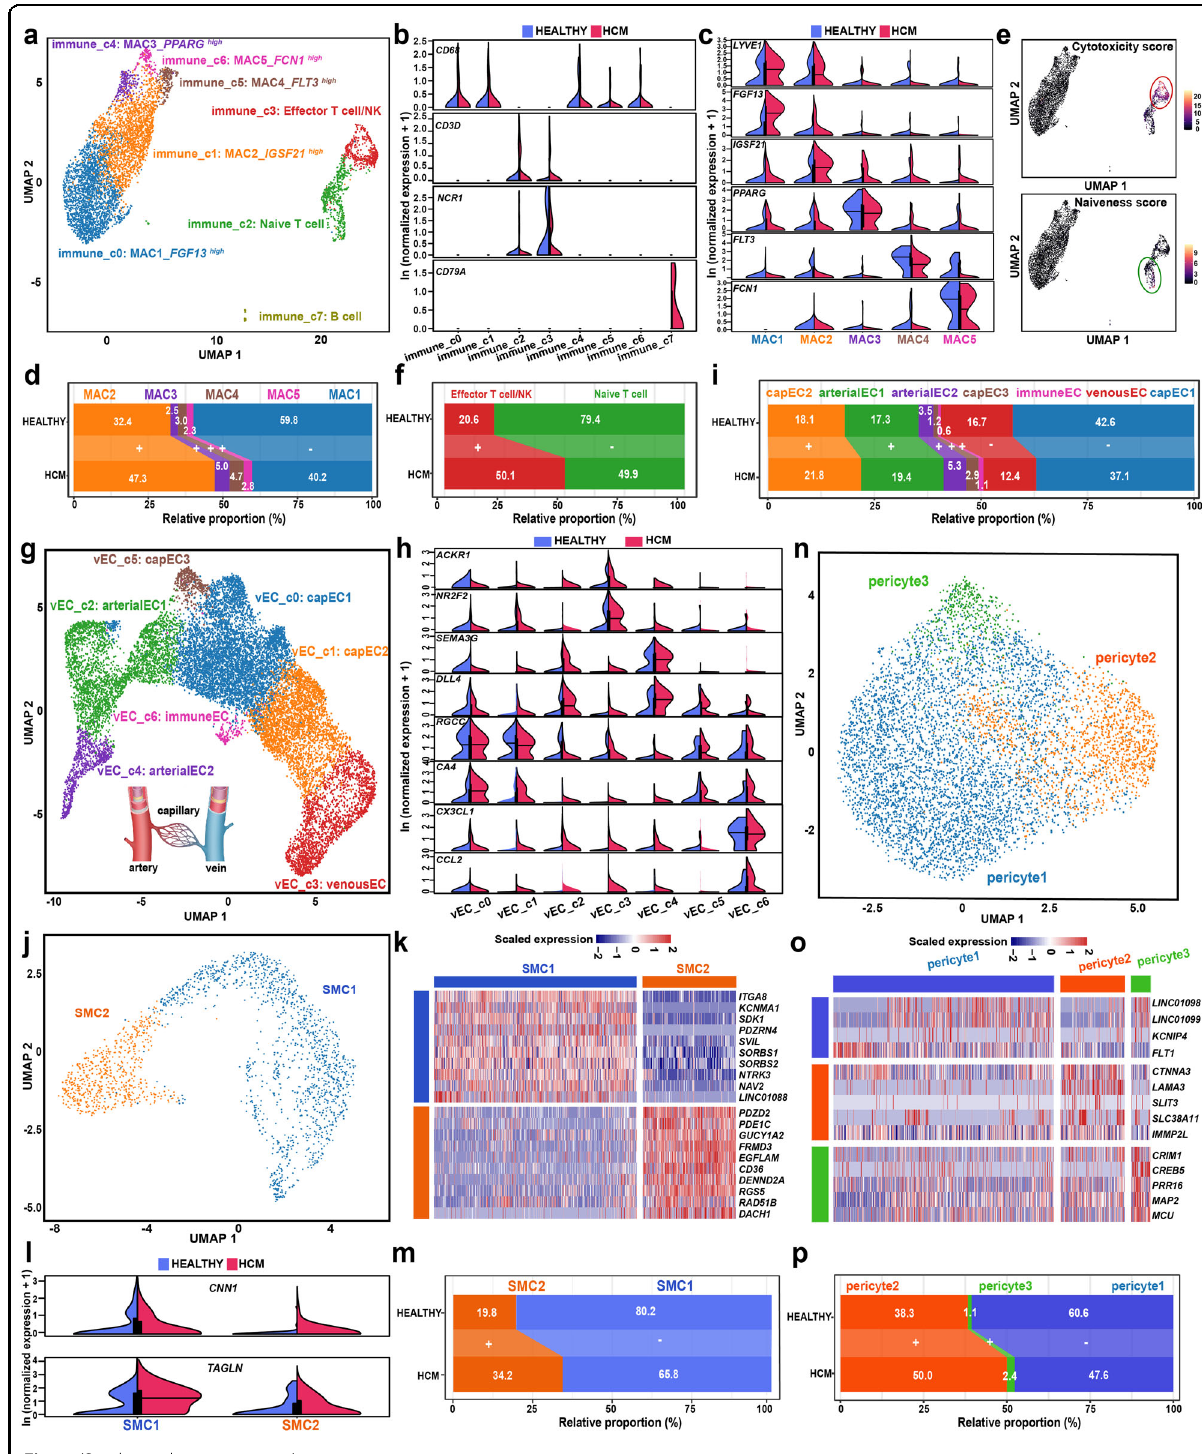
Fig. 4 (See legend on next